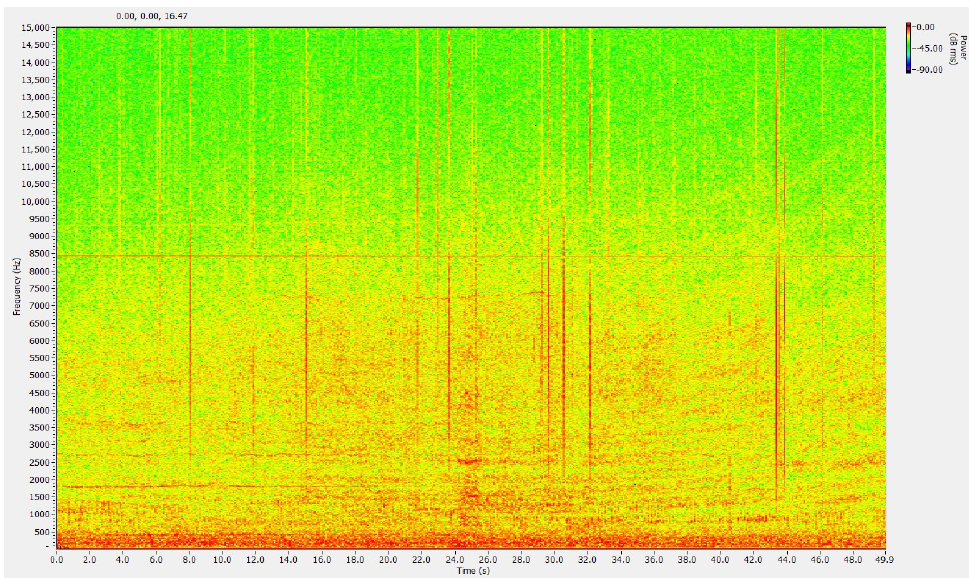
Figure 15. Signal energy chromatogram at substation